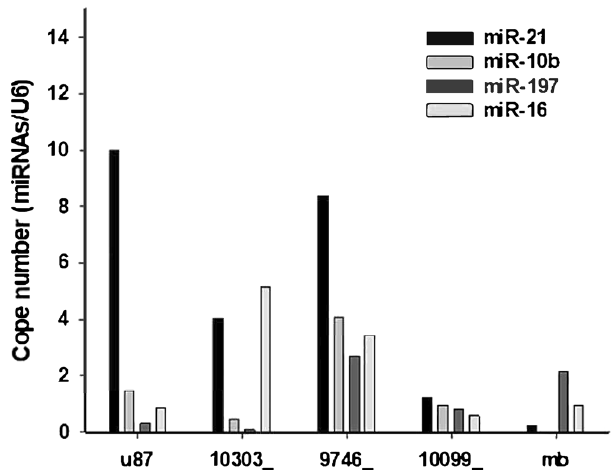
Figure 5. Relative miRNA expression in GBM tissues and cancer cell lines. In this study, the relative expression levels of four miRNAs, miR-21, miR-10b, miR-197, and miR-16, were used to detect GBM BVZ subtypes. The relative expression of miRNAs is expressed as the relative copy numbers of U6. In this picture, 10303_, 9746_, and 10099_ are GBM brain tissue samples, and U87 and mb are a GBM cell line and an MB cell line,